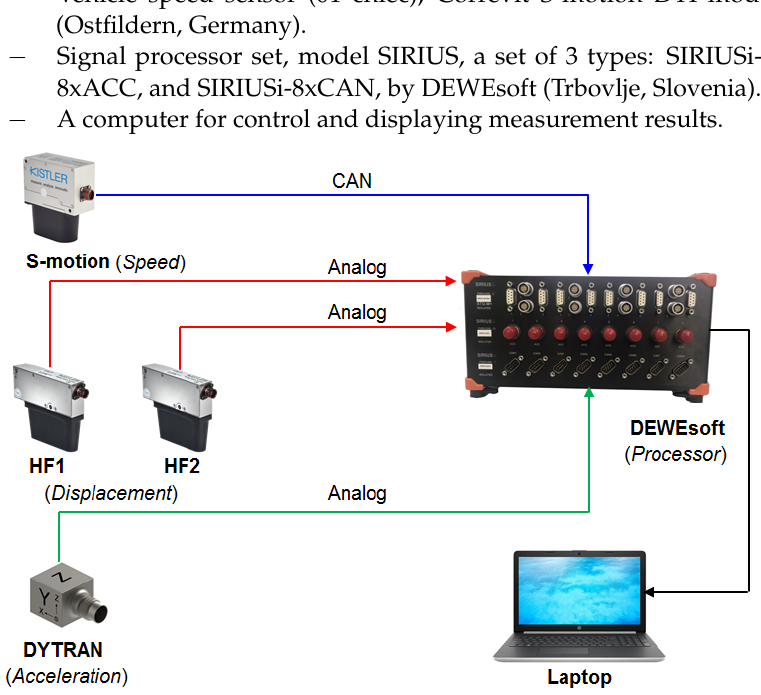
Figure 6. Connection diagram of experimental equipment .